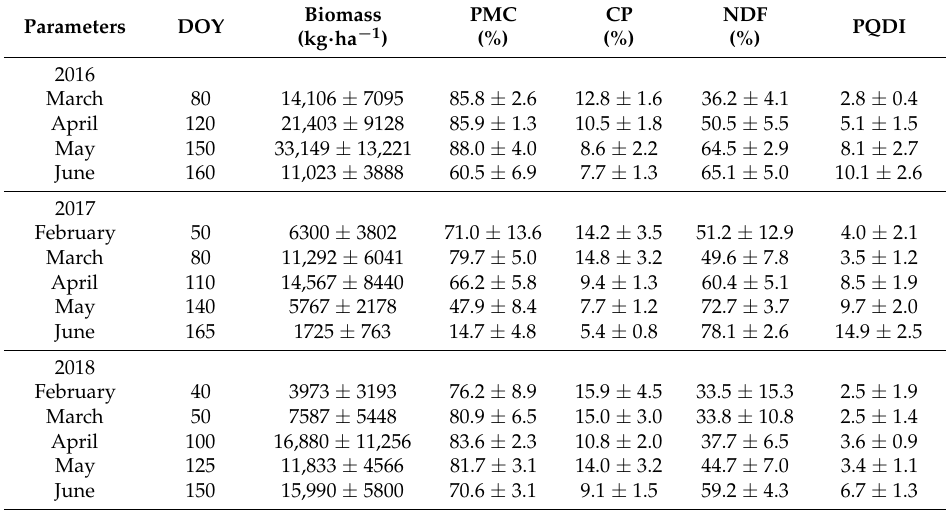
Table 2. Descriptive statistics (mean ± standard deviation) of pasture parameters, measured at the 12 sampling points of the studied field, for each sampling date (between February or March and June)